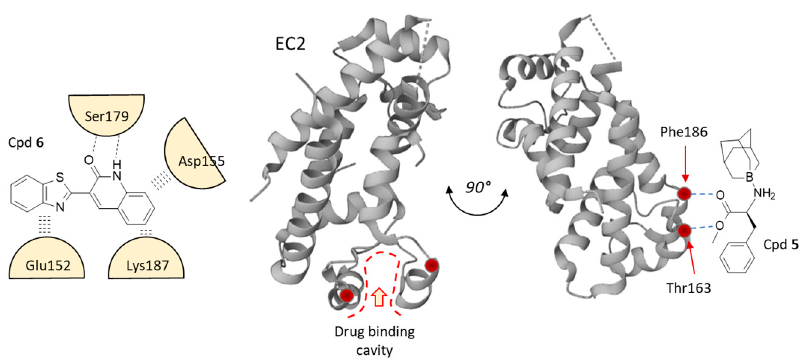
Figure 5. Small molecules identified as CD-81 binders. The binding of these molecules to the large extracellular loop (EC2) of CD-81 has been evidenced experimentally and/or proposed on the basis of computational studies (see Table 2). Table 2. Small molecules interacting with CD81.